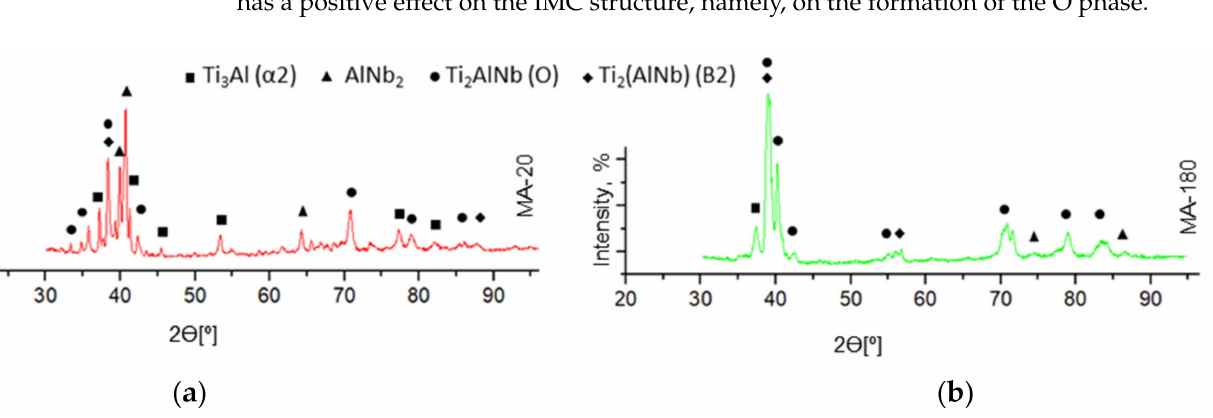
Figure 5. The X-ray results of samples sintered at 1300 ◦ C/5 min/20 MPa: ( a ) MA-20; ( b )